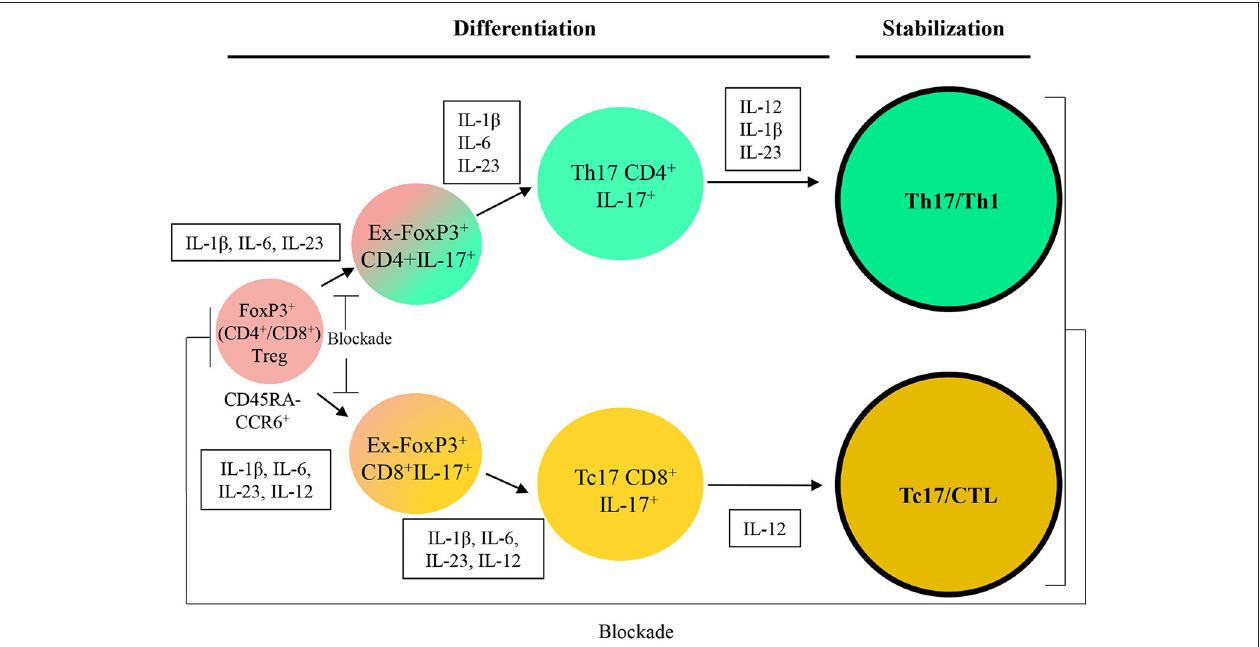
FIGURE 3 | A therapeutic approach based on Treg/Th17/Th1 axis. IL, Interleukin ; CCL, C-C motif chemokine; CXCL, Chemokine (C-X-C motif) ligand; APC, Antigen-presenting cells; TGF- β , Transforming growth factor beta; PDL-1, Programmed death-ligand 1; MHC, Major histocompatibility complex ; MDSC, Myeloid-derived suppressor cell; Arg-I, Arginase I; iNOS, Inducible nitric oxide synthase; TAM, Tumor -associated macrophage; IFN- γ ,